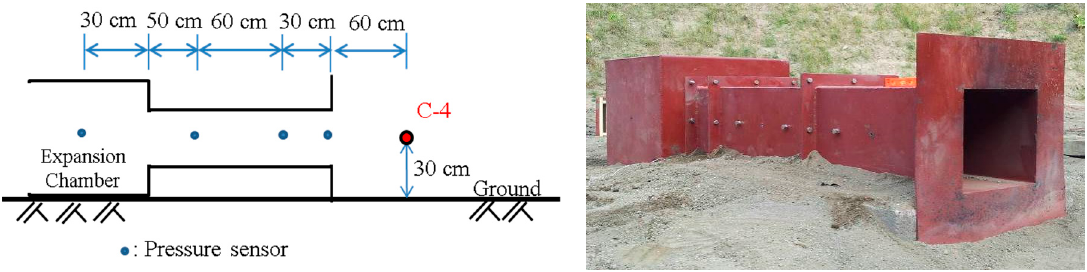
Figure 1. Experimental configuration and specimen of the linear tunnel with expansion chamber.